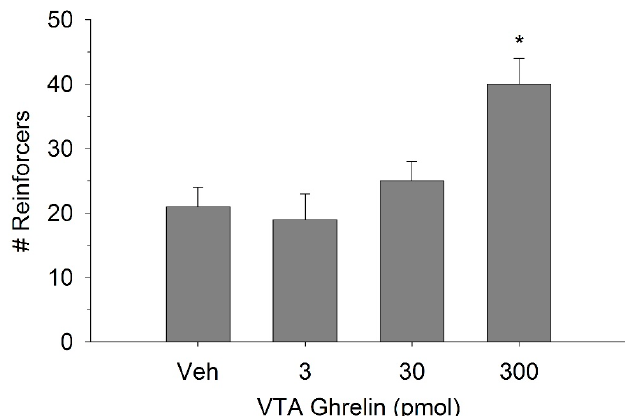
Figure 1. Ghrelin administration into the ventral tegmental area (VTA) increased operant responding for food reward. Values represent mean number of reinforcers (sucrose pellets) ± SEM; n = 8. * p < 0.05 compared to vehicle (Veh).